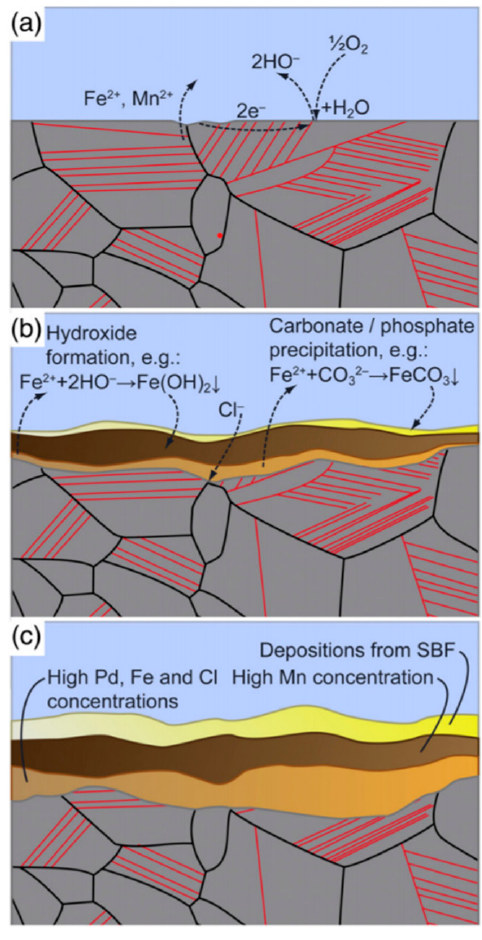
Figure 8. Schematic illustration of the degradation process and the formation of degradation prod- ucts for TWIP-1Pd alloys: ( a ) Initiation of the corrosion reaction: The anodic partial reactions are the metal oxidation, whereas the cathodic partial reaction is oxygen reduction, ( b ) formation of hydroxides/oxides, and precipitation of carbonates and phosphates that comprise the degradation products. Cl − ions diffuse to the surface, causing localized attacks, and ( c ) further build-up of degradation products. The Pd remains in the layer close to the sample surface and acts as a macrogal- vanic element to increase degradation [92]. (Reproduced with permission from refs. [92]. Copyright (2013),